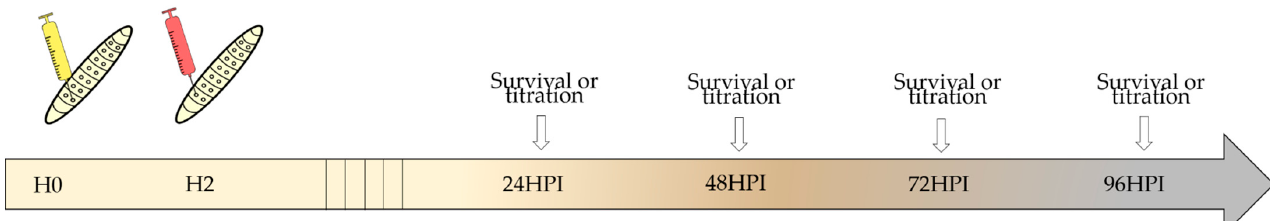
Figure 1. Representation of the survival and titration experiments of Galleria mellonella larvae. Larvae were inoculated at 2-h intervals. Survival assessment and phage: bacterial titrations were performed every 24 h for 96 h. HPI: hours post inoculation.